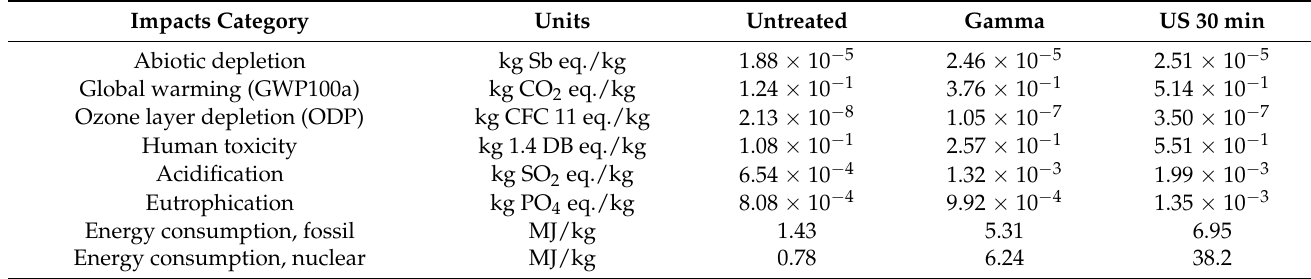
Figure 13. Normalised comparison of two fibre pre-treatments (Gamma and US 30 min) for six impact indicators decom- posed according to the sources—scutching flax tows are included. Table 4. Environmental impacts for the production of scutching native flax tows, flax tows pre-treated using the Gamma and US 30 min